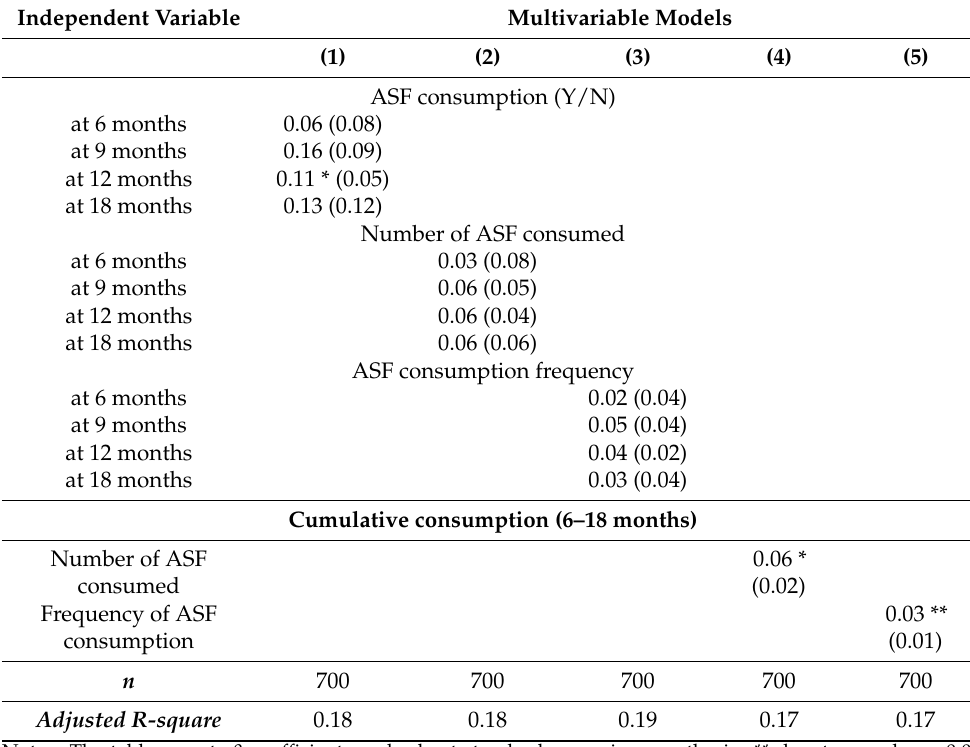
Table 5. Association of total LAZ scores and ASF